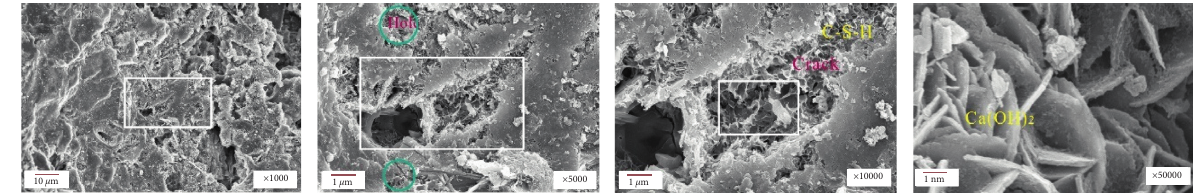
Figure 21: C-6 concrete microstructure before sample freeze-thaw.